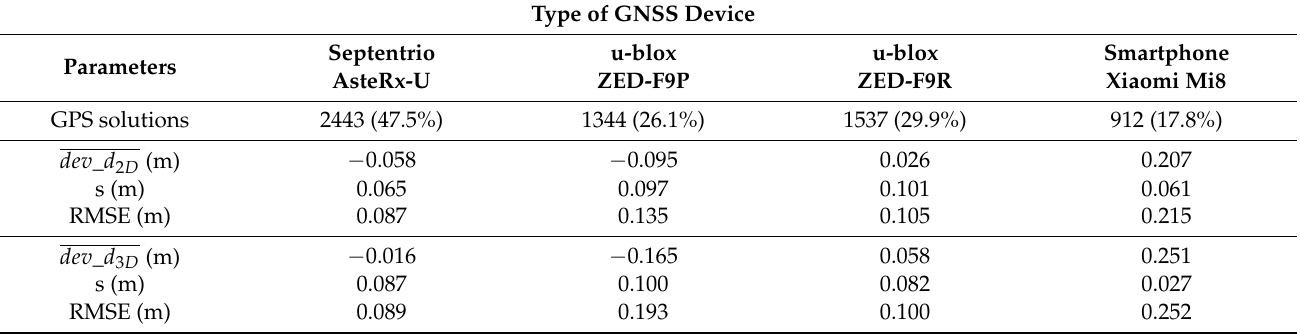
Table 5. Statistics (mean, standard deviation, and RMSE) for GPS solutions for filtered values of deviation in distances that were below 30 cm. Situation: entire trajectory (static and kinematic: 5148 total